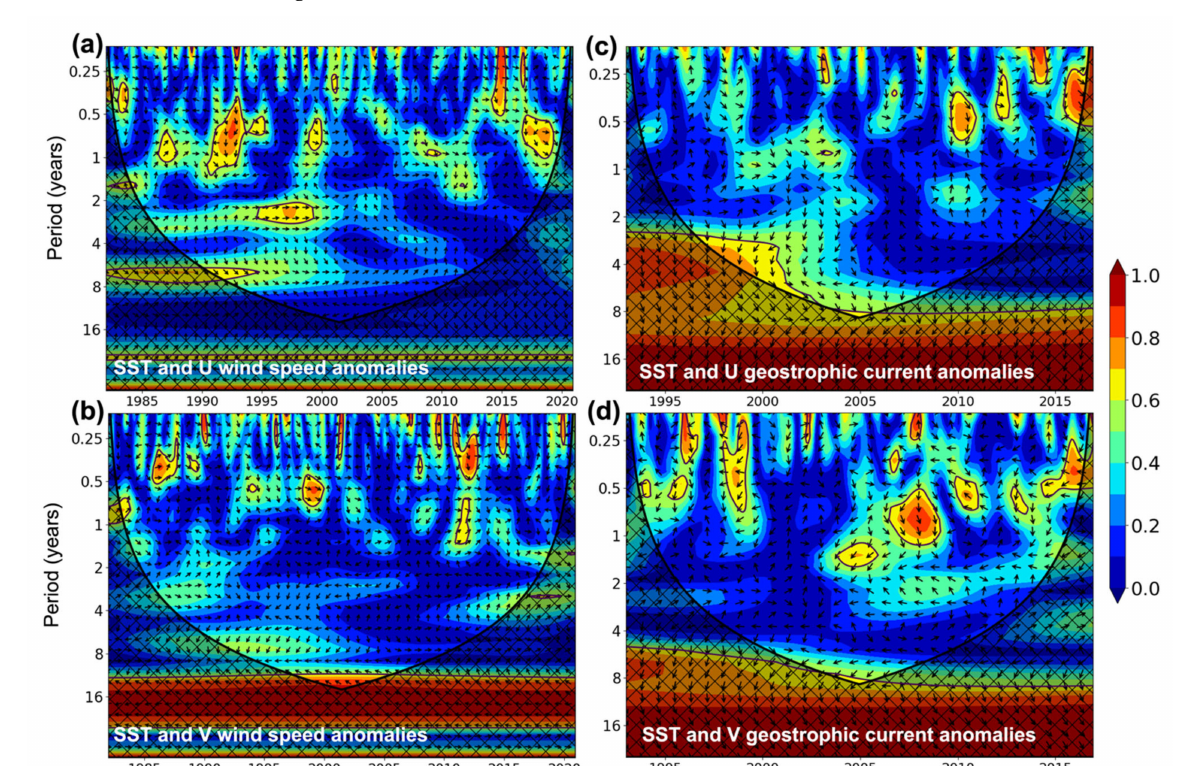
Figure 9. The wavelet coherence between standardized monthly anomalies of ( a ) Sea Surface Temper- ature (SST) and zonal (U) wind speed, ( b ) SST and meridional (V) wind speed, ( c ) SST and zonal (U) geostrophic current speed, and ( d ) SST and meridional (V) geostrophic current. Note the different time series lengths. The relative phase relationships are shown as arrows (with in-phase pointing right, anti-phase pointing left). The 95% confidence level regions are highlighted in red and circled by a black contour. The cross-hatched regions are insignificant due to the effect of zero